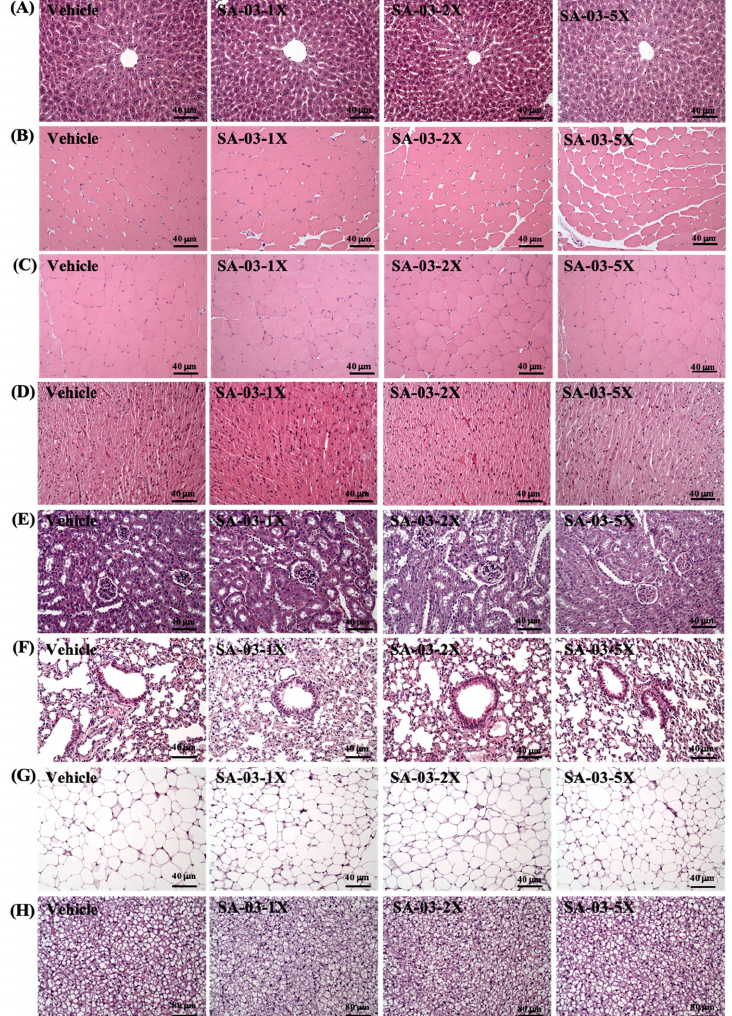
Figure 9. Effect of SA-03 supplementation on ( A ) liver, ( B ) muscle, ( C ) quadricep muscles, ( D ) heart, ( E ) kidney, ( F ) lung, ( G ) adipocyte tissue, and ( H ) BAT tissue in mice. (H&E stain, magnification: 200×; bar, 40 µm; BAT magnification: 100×; bar, 80 µm).